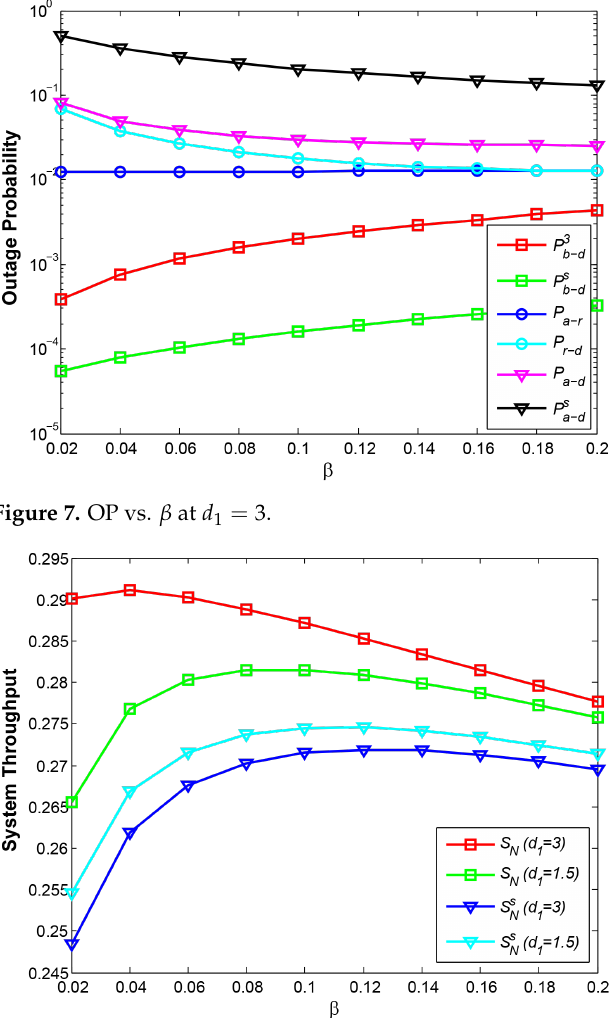
Figure 8. System throughput vs. β at d 1 =